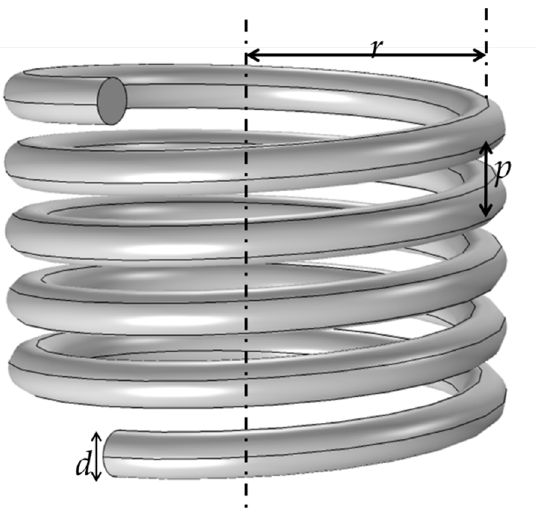
Figure 2. The coil dimensions including the radius of the solenoid ( r ), the diameter of the enameled wire ( d ), and the wire spacing ( p ).